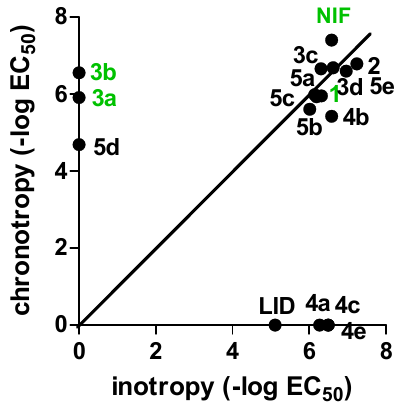
Figure 3. Design strategy for the studied compounds 4a – e and 5a – e .